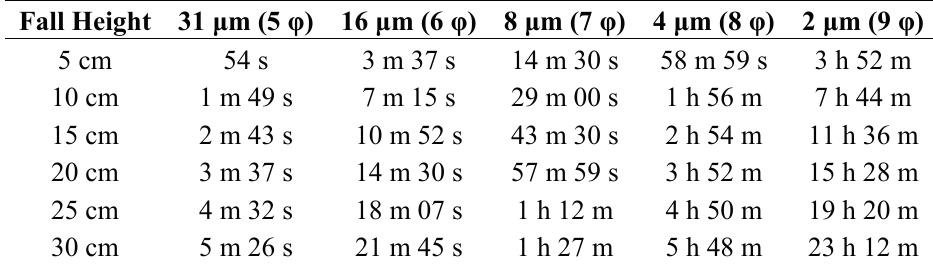
Table 1. Calculated settling times using Equation (1) to calculate fall velocity for a range of particle sizes over six fall heights. Timings are calculated using the density of quartz 2650 kg·m − 3 and the density (998 kg·m − 3 ) and viscosity (1.002 × 10 − 3 kg·m − 1 ·s − 1 ) of water at 20 °C. “h” = hour(s), “m” = minute(s), “s” = second(s). Micrometer sizes ( μ m) are given as an approximation of phi ( φ )